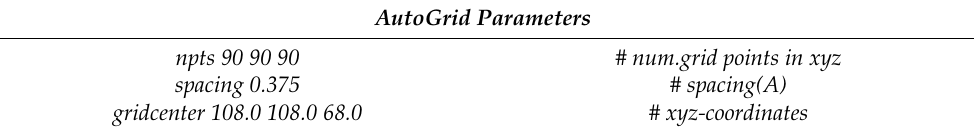
Table 7. AutoGrid